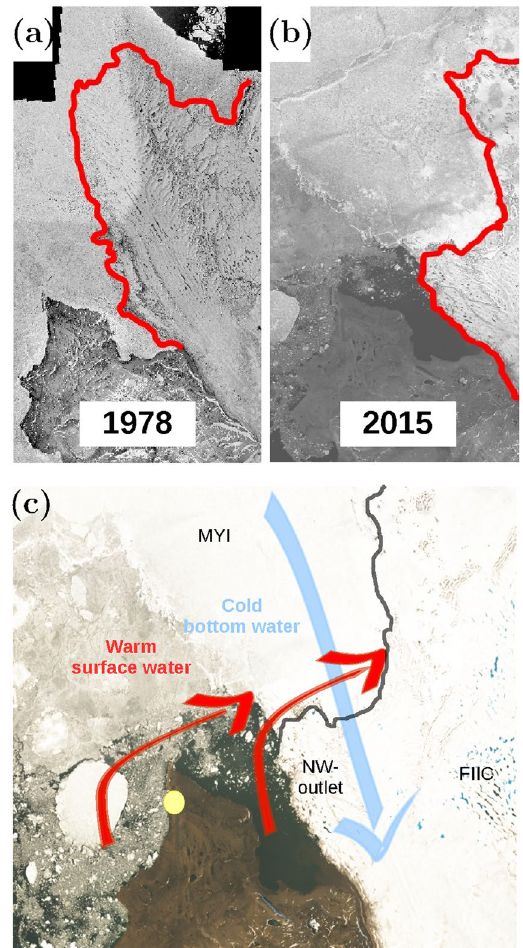
Figure 6. Melt due to open water. ( a ) FIIC in 1978 and (b) 2015. (c) Conceptual figure showing transport of warm surface water (red) and relatively cold bottom water (blue) below the ice shelf. (a) is based on orthophotograph from Korsgaard et al . 44 (http://www.nature.com/articles/sdata201632) licenced under CC BY 4.0 (https://creativecommons.org/licenses/by/4.0/) ( b ) and ( c ) are enlargements of the Landsat 8 satellite image shown in Fig. 1a (Landsat 8 data compiled by the U.S. Geological Survey and processed as in Fig. 1). The location of Villum Research Station (yellow bullet) and the NW-outlet glacier are shown. Relatively thin permanent ice cover and thick multi-year ice (MYI) cover the western and eastern portion of the area, respectively.